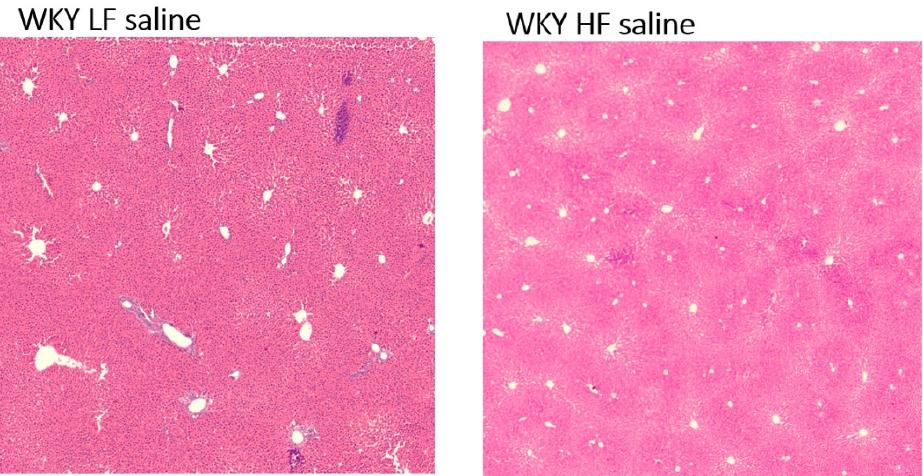
Figure 7. Liver histology, representative photomicrographs of WKY LF saline and WKY HF saline (n = 6). Eosin-hematoxylin staining. The magnification of photomicrographs is 200×. Using untargeted lipidomic profiling of liver homogenates, we identified a total of 145 lipids. PCA (Figure 8A) based on lipid profiling revealed a clear separation between WKY HF saline and WKY LF saline. The heatmap in Figure 8B shows the comparison of intensities of the top 20 lipid features, based on statistical significance according to one-way ANOVA. Both methods clearly show changes in liver lipid profiles between WKY HF saline and WKY LF saline rats. In the volcano plot (Supplementary Figure S2), the diacylglycerols (DG) and phosphatidylcholines (PC) containing mostly saturated—SFA (16:0, 18:0) and monounsaturated fatty acids—MUFA (16:1, 18:1). On the contrary, HF